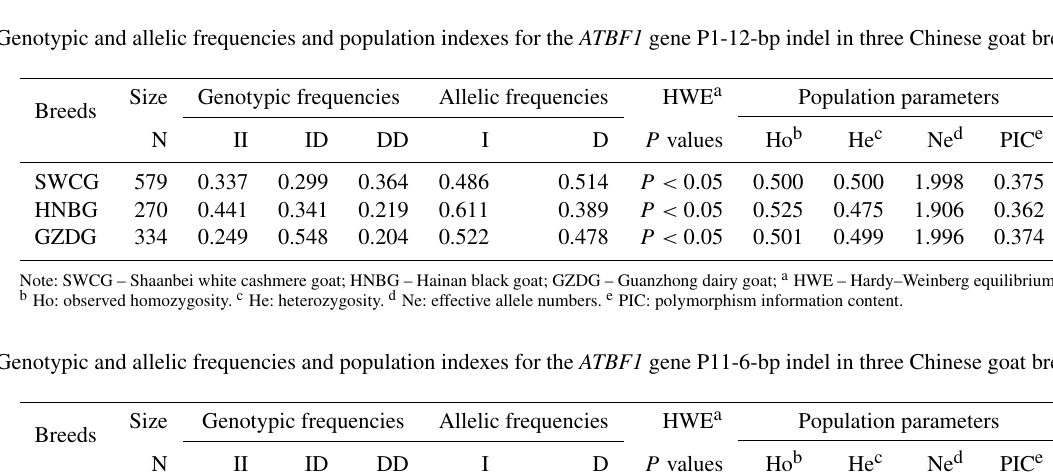
Table 3. Genotypic and allelic frequencies and population indexes for the ATBF1 gene P11-6-bp indel in three Chinese goat breeds. Size Genotypic frequencies Allelic frequencies HWE a Population parameters Breeds N II ID DD I D P values Ho b SWCG HNBG 238